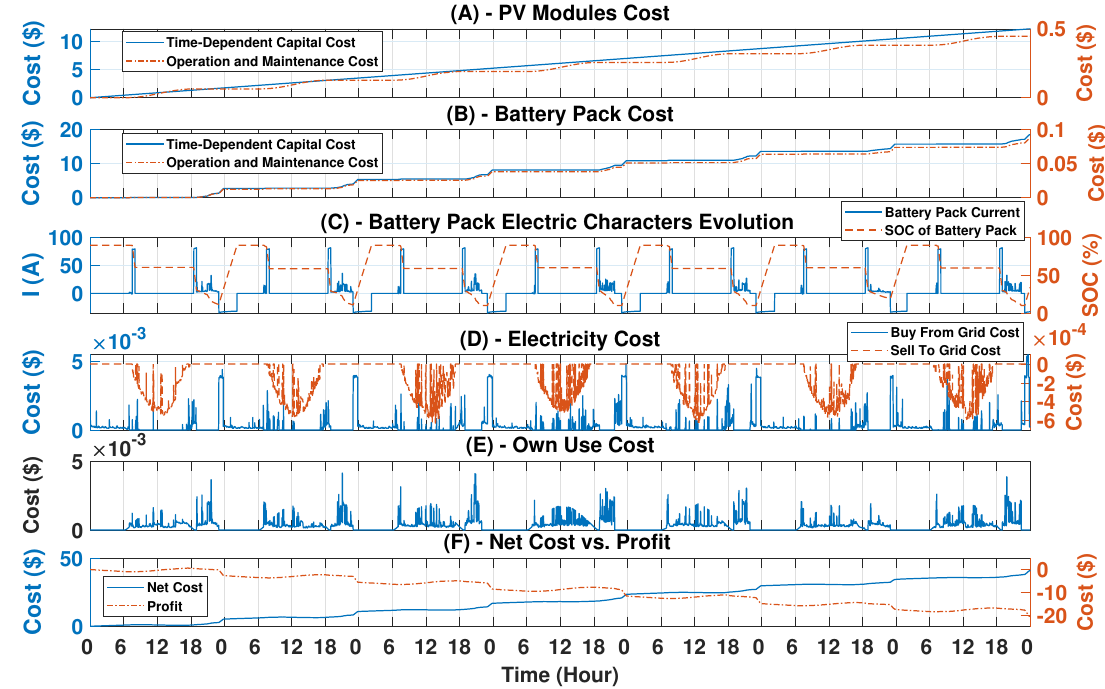
Figure 17. Five-day simulation with cost quantities of the EES corresponding to Figure